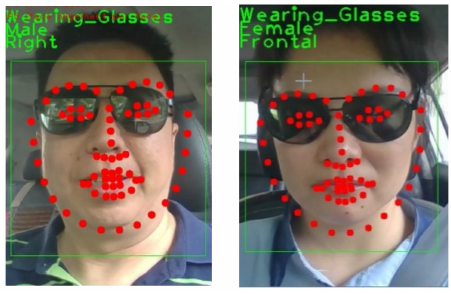
Figure 4. Facial landmarks with